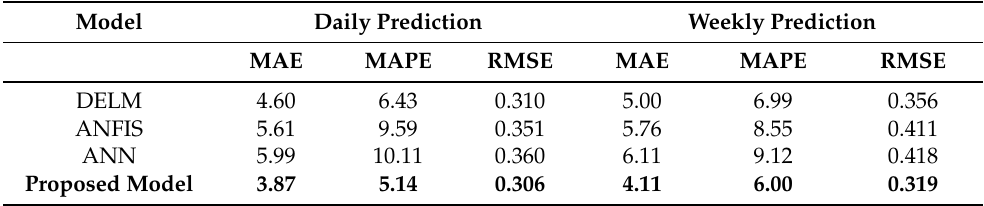
Table 5. Comparative analysis of proposed ensemble model with DELM, ANFIS, ANN on daily and weekly apartment level forecasting with clustering. Model Daily